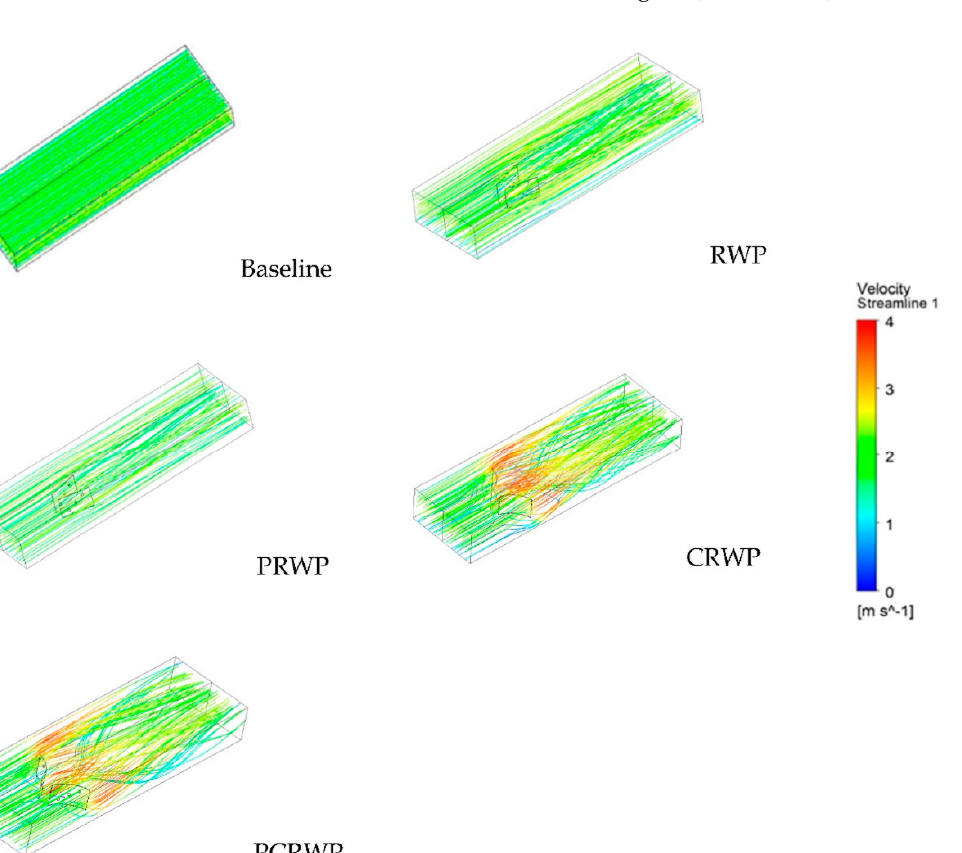
Figure 7. Tangential velocity vector on the use of perforated RWP and CRWP VGs.